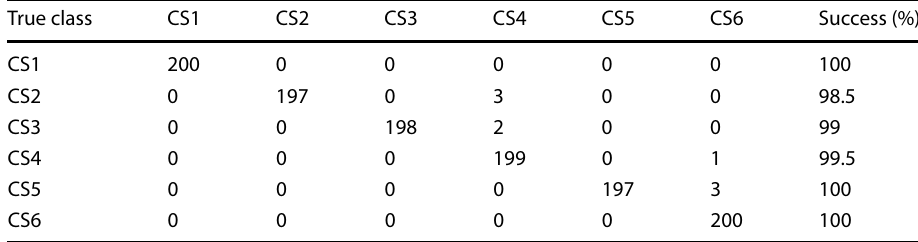
Overall success rate (%):